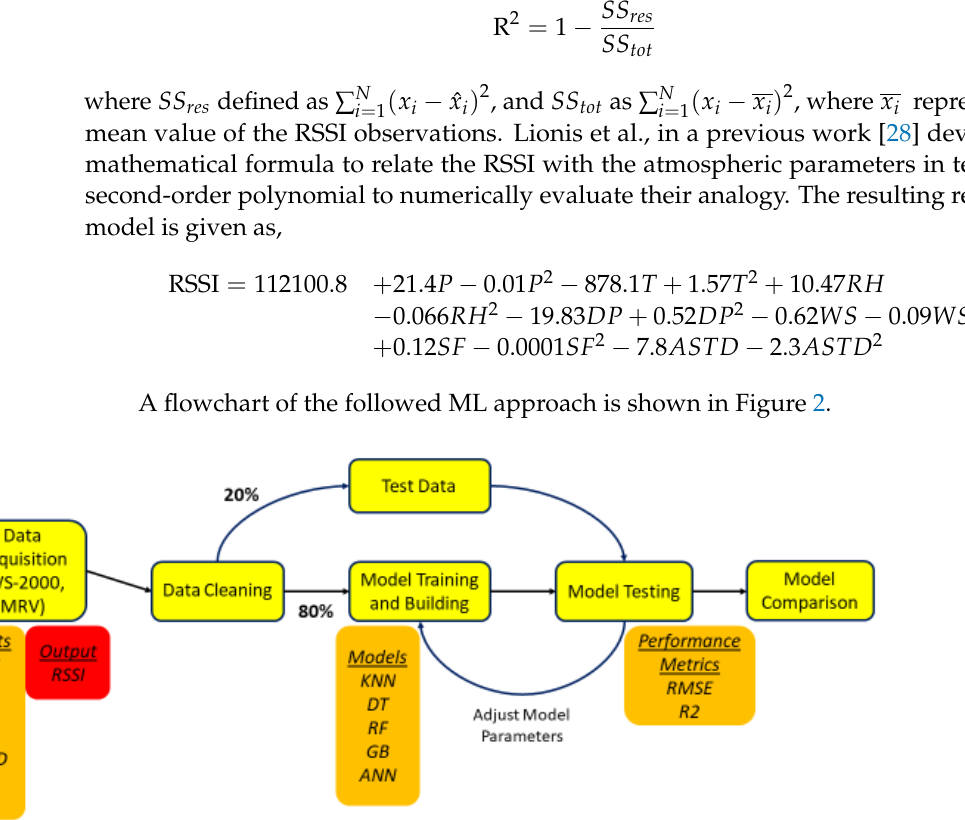
10 Figure 3. Matrix of linear correlation coefficients for measured meteorological parameters and RSSI.